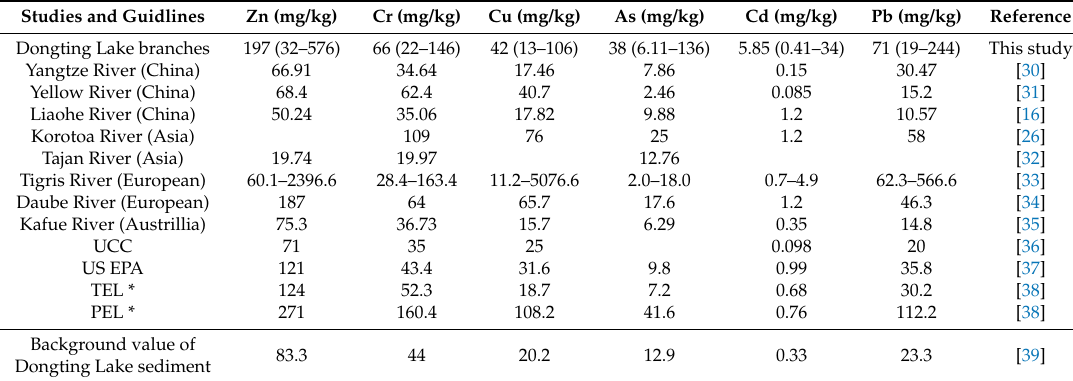
Table 2. Comparison of metals in sediment with different national and international guidelines and studies about rivers.